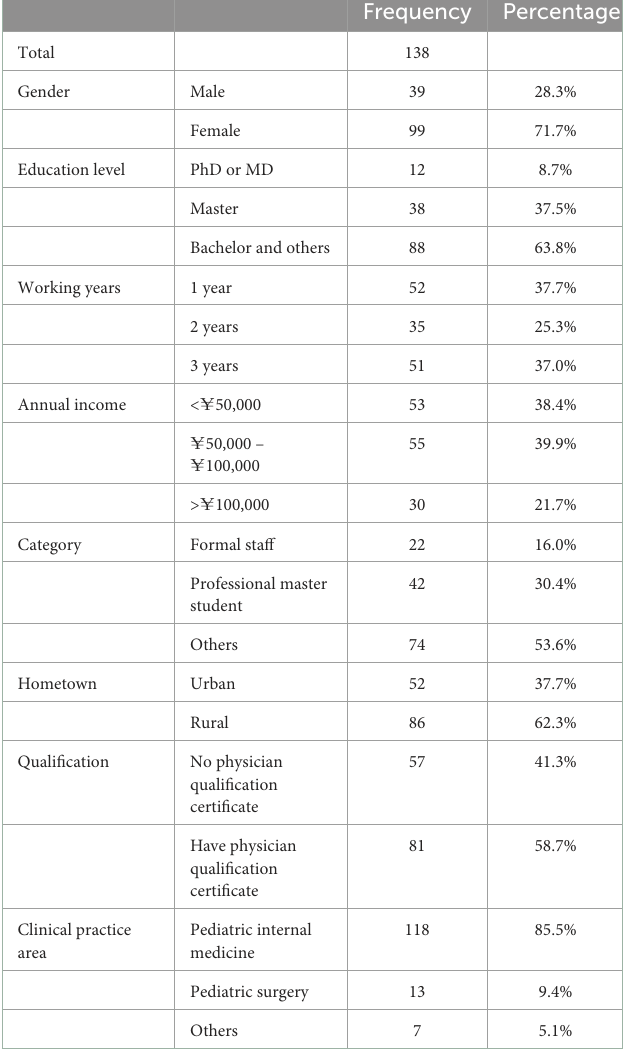
TABLE 1 Socio-demographic characteristics of the